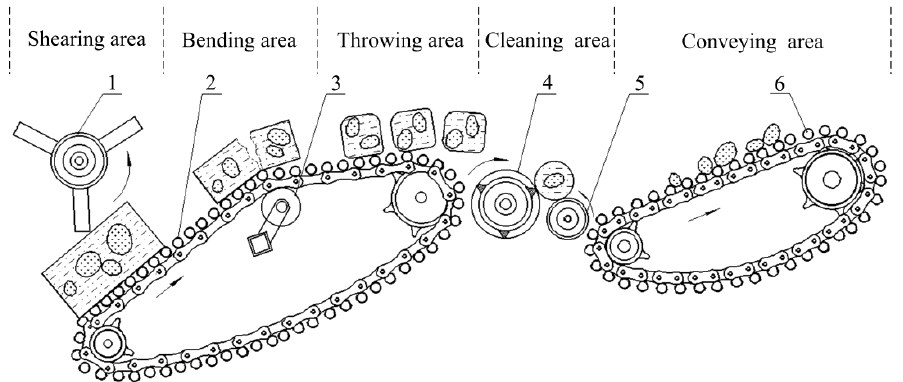
Figure 2. Schematic diagram of potato-soil separation device. 1—Soil-crushing mechanism; 2—first-stage lifting chain; 3—support wheel; 4—rubber roller; 5—smooth roller; 6—second-stage lifting chain.